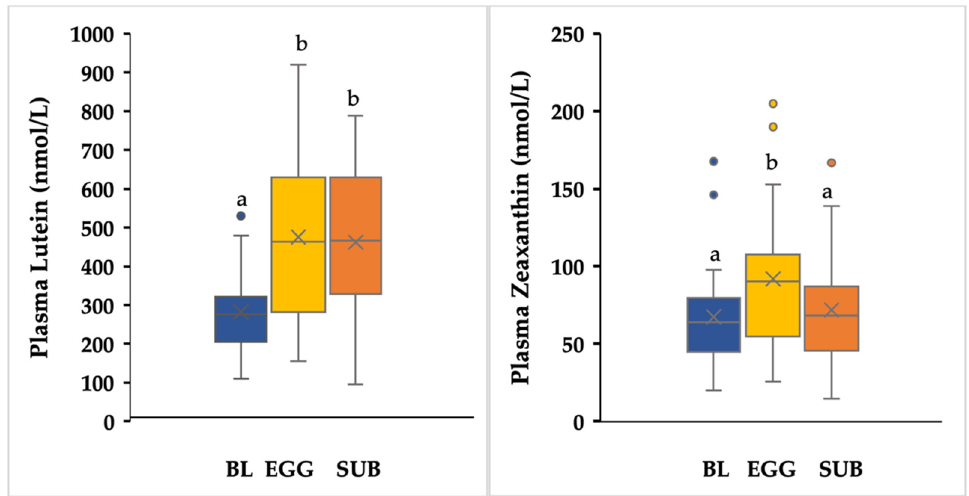
Figure 3. Concentrations of lutein and zeaxanthin at baseline (BL) and following the EGG and SUB intervention. Both EGG and SUB interventions resulted in higher concentrations of lutein ( p < 0.01), but only EGG increased plasma zeaxanthin ( p < 0.01) as indicated by different superscripts (a,b). Values are presented as mean ± SD.